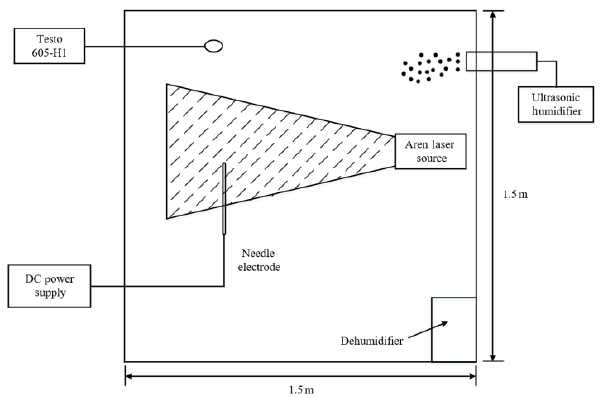
Figure 3. (a) Nitrogen species dominate the optical emission spec- tra (shown between 300 and 400nm here) from the negative corona discharge on the wire electrode generated with the applied volt- age of − 40kV. (b) An image of corona discharge on the wire (1m length, − 40kV). The exposure time of the image is 0.5s. The wire (diameter of 1mm) was composed of six strands of